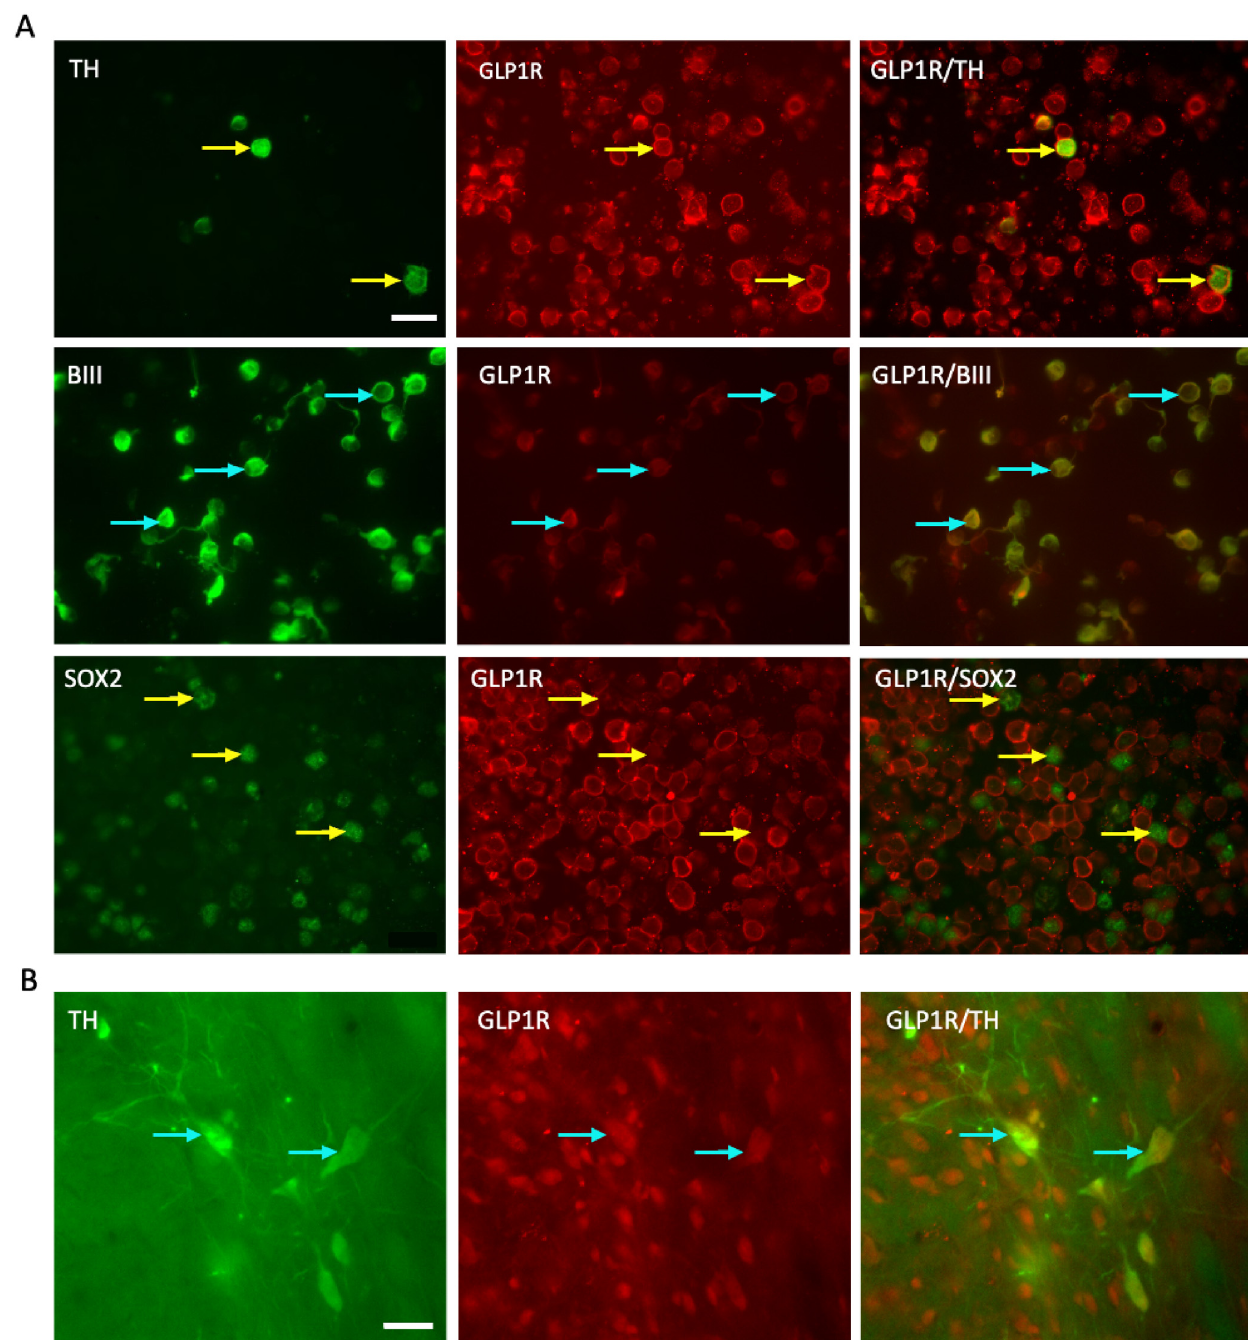
Figure 2. GLP-1R expression on the E14 VM cells and dopaminergic neuronal graft in the striatum. ( A ) florescent images showing co-expression of GLP-1R (red) with TH+ cells (green), BIII tubulin+ cells (green) and SOX2+ cells (green) in E14 VM cells before grafting. ( B ) florescent images showing GLP-1R expression with TH+ cells in the grafted striatum after 13 weeks of transplantation (The arrow points to the co-localised points). Scale bar ( A , B ) = 20 μ m. TH = tyrosine hydroxylase; GLP-1R = glucagon like peptide -1 receptor.